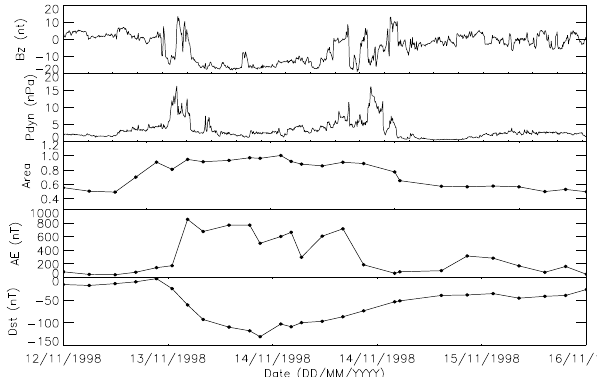
Figure 7. B z (top panel), P dyn (second panel), the normalized area (third panel), the AE index (fourth panel), and the Dst index (bot- tom panel) as a function of time during 12–16 November 1998. The x coordinate of black dots in the third panel represents the selected time at which the CRWs are calculated. Note that the y axis of the area panel has been normalized.